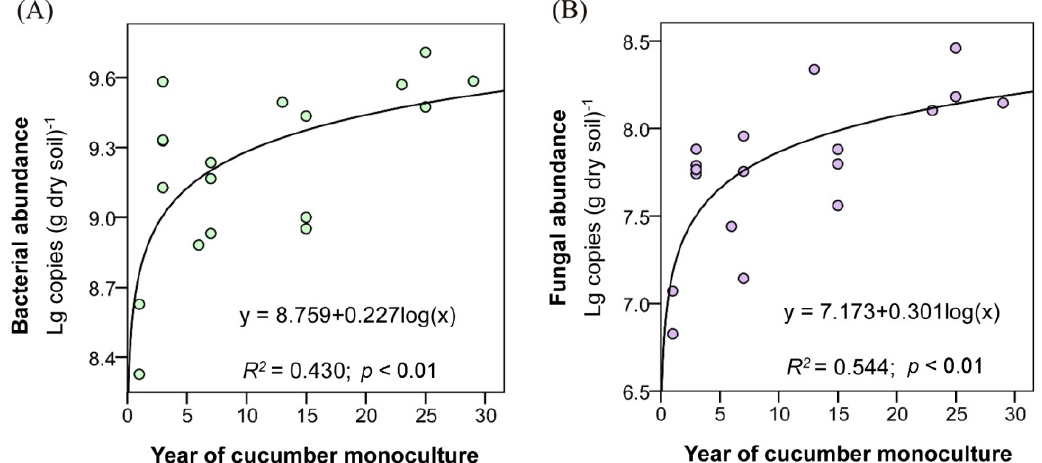
Figure 1. Relationship between the rhizosphere bacterial ( A ) and fungal ( B ) abundance and the cucumber monoculture years in greenhouses. Regression results are presented in the figure, where x is the period (year) of cucumber monoculture, and y is abundance. Table 2. Correlation of soil microbial alpha diversity with a period of monoculture and soil properties in 25-year cucumber monocultures in greenhouse conditions.